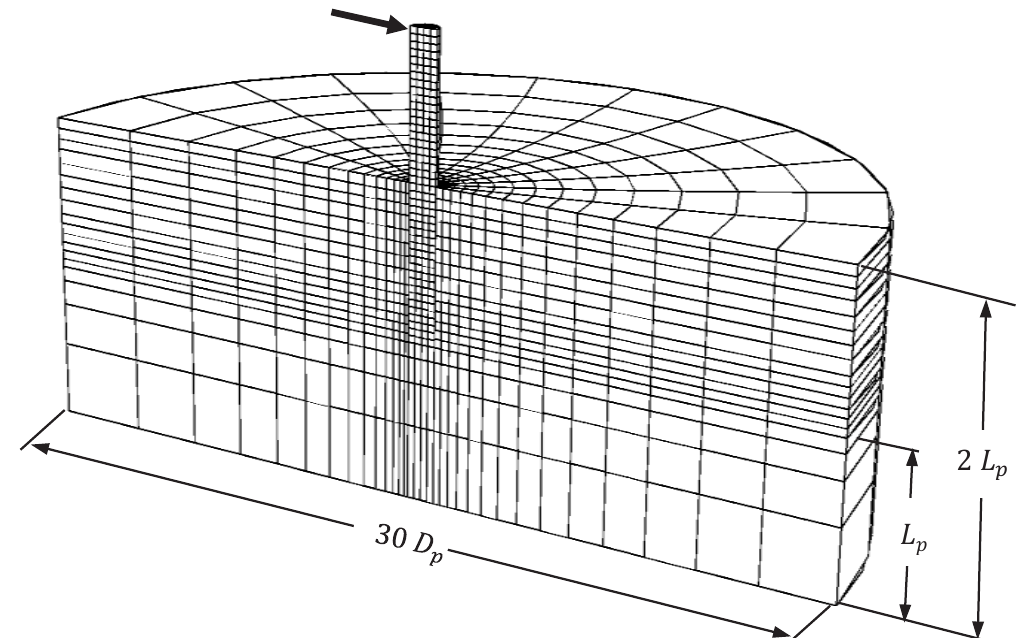
Figure 2: FE mesh used to analyze soil–monopile interaction.